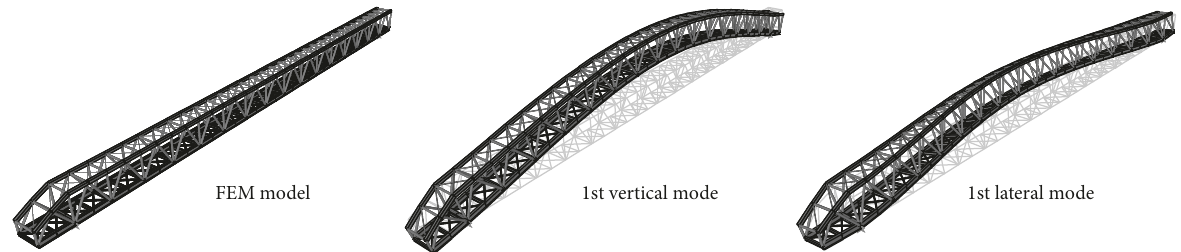
Figure 10: 3D SAP2000 Finite Element model of the truss footbridge, and first lateral and vertical mode